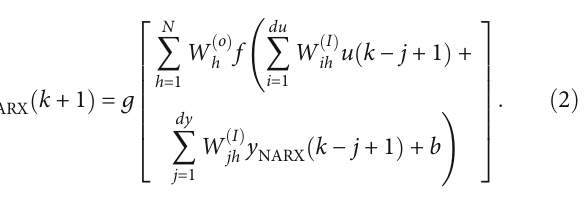
Learning algorithm